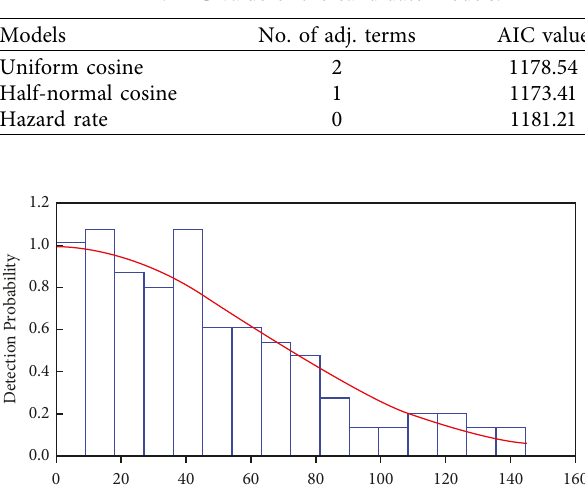
Table 1: AIC value of the candidate models.